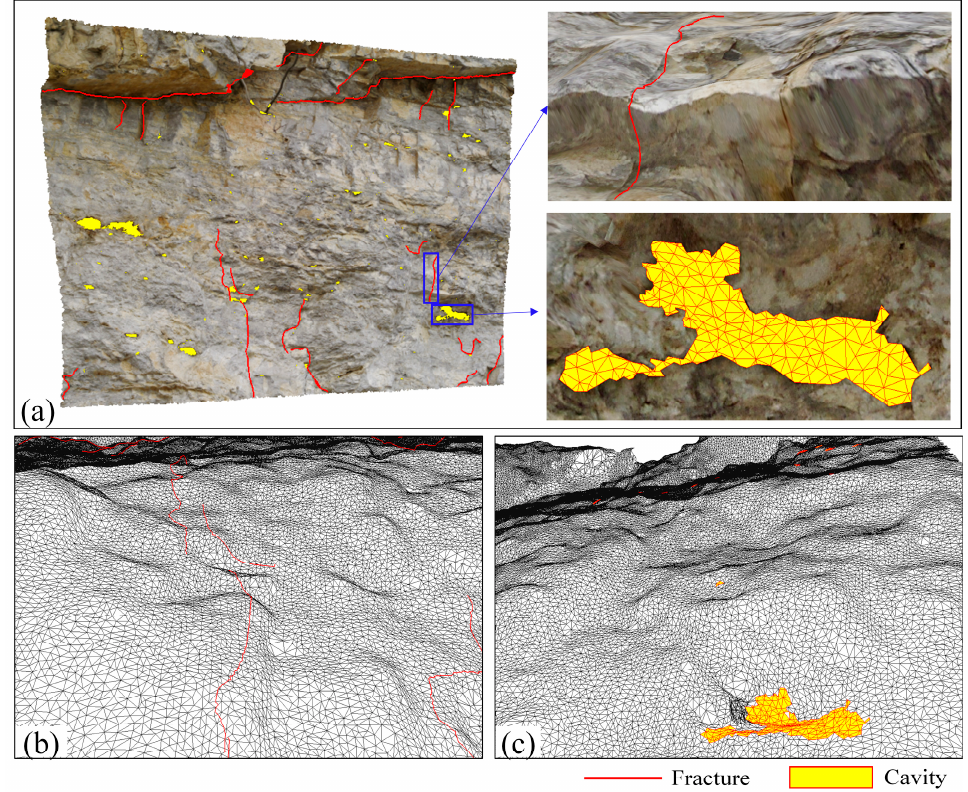
Figure 8. 3D Rending results of fractures and cavities: ( a ) Overall effect; ( b ) polylines (fractures); ( c ) polygons (cavities) rendering over the skeleton model.